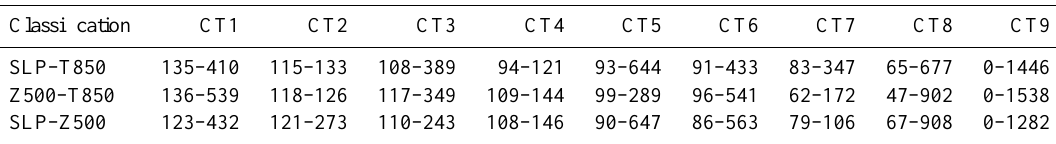
Table 7. Number of days classified within each CT. Each box shows the number of days classified before and after the allocation process. CT9 denotes the unclassified